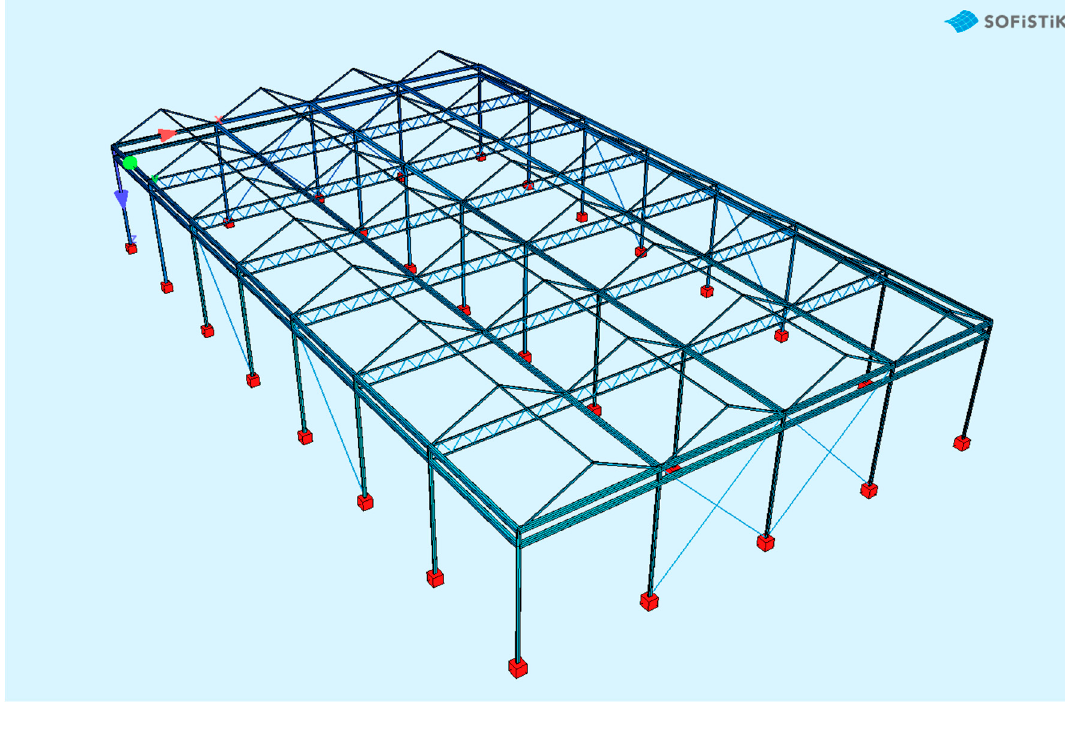
Figure 14. The 3D model of the Venlo-type greenhouse.